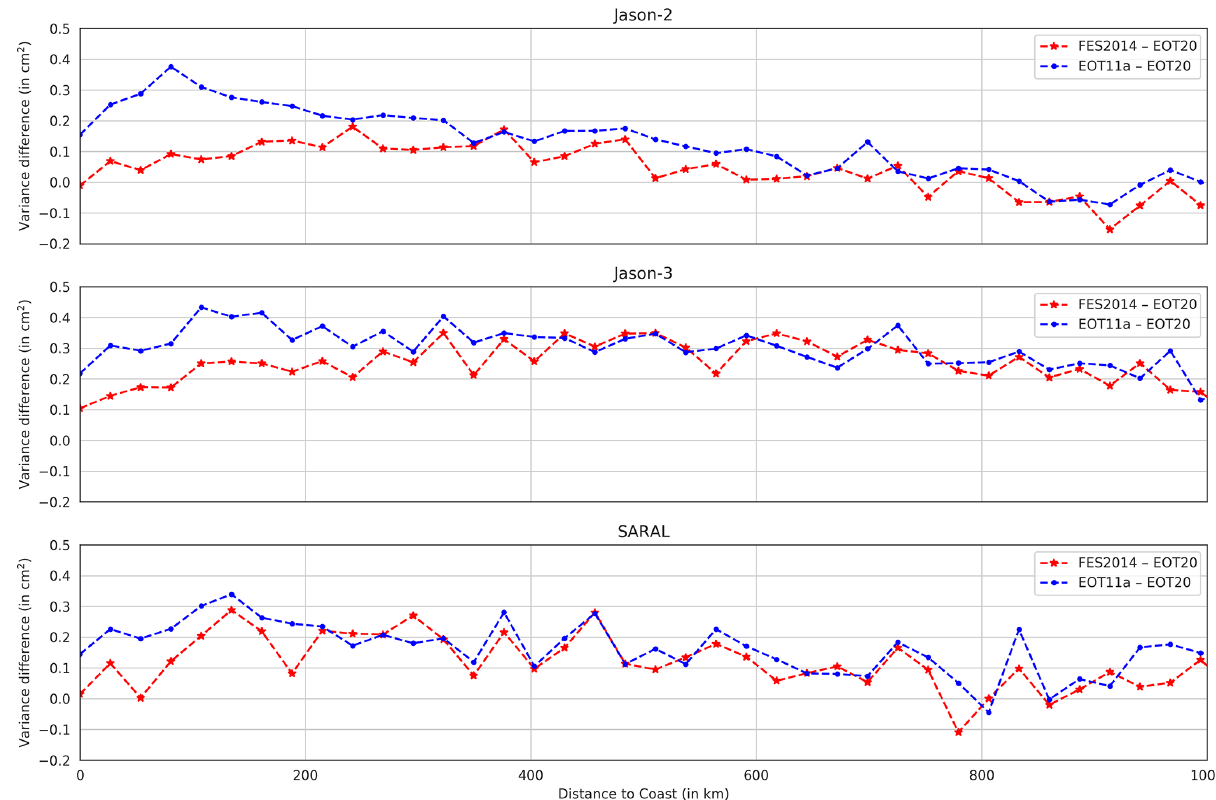
Figure 7. A line graph showing the mean SLA variance differences between the tide models as a function of distance to coast (in km) for all three satellite altimetry missions. The red line represents FES2014 − EOT20, while the blue line represents EOT11a −